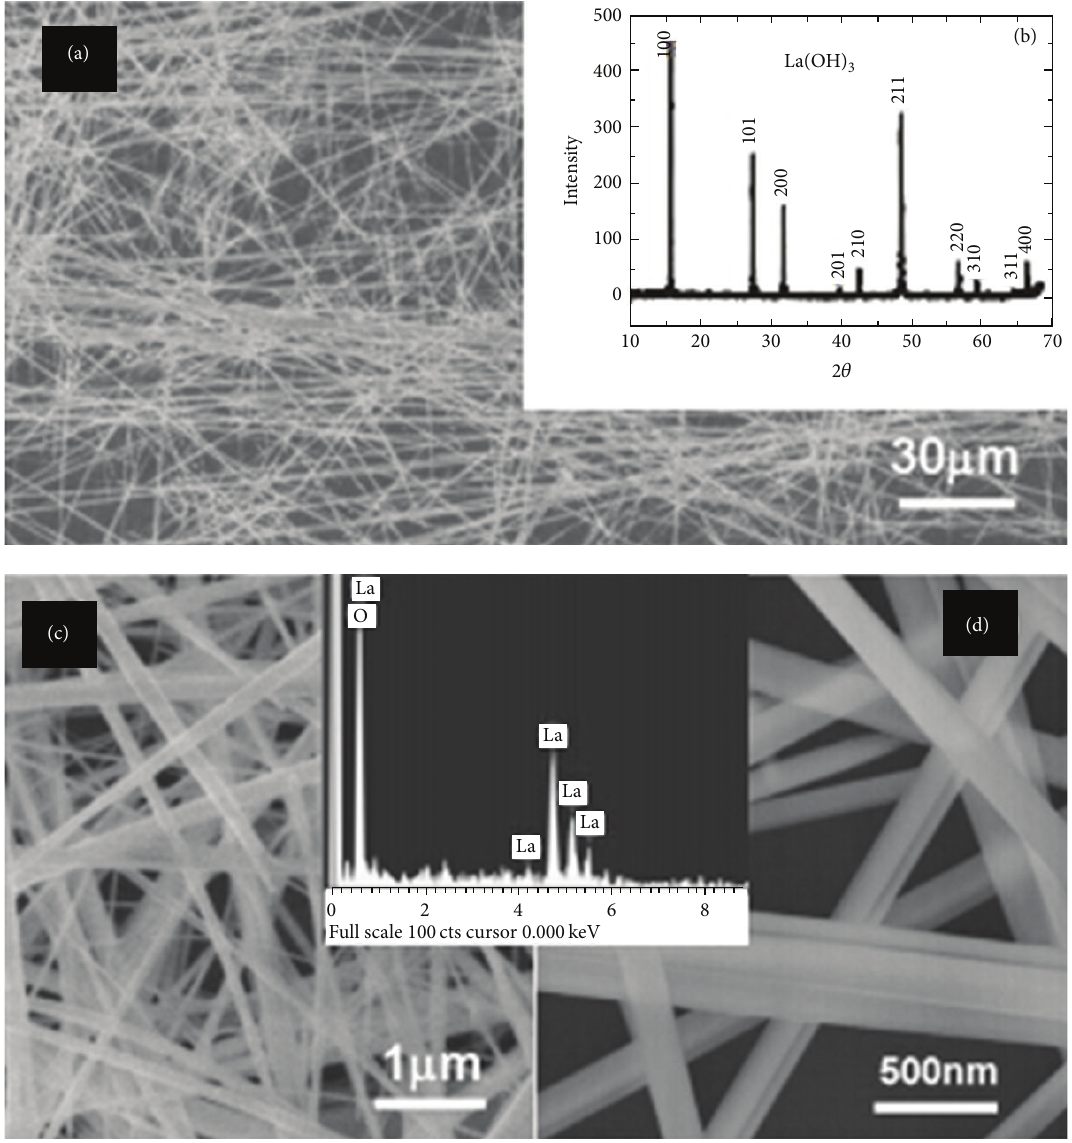
Figure 2: (a) Low-magnification SEM image of the La(OH) 3 products. (b) A typical XRD pattern of the as-synthesized La(OH) 3 product. (c) and (d) are the high-magnification SEM images of the La(OH) 3 product [10].